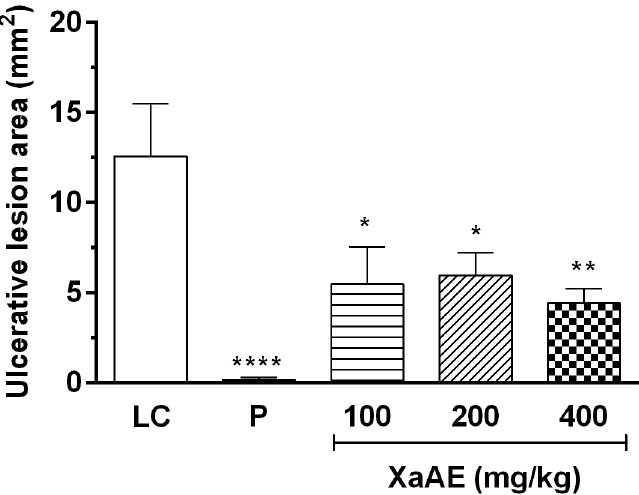
Figure 7. Gastroprotective effect of the aqueous extract of X. americana (XaAE ) stem bark on indomethacin-induced (30 mg/kg, s.c.) gastric lesions in Wistar rats. Animals received 0.9% NaCl solution (lesioned control, LC, 10 mL/kg, orally), pantoprazole (P, 40 mg/kg, orally) or XaAE (100, 200 and 400 mg/kg, orally). Results were expressed as mean ± SEM (6–8 animals/group). Statistically different when compared to the lesioned control group (ANOVA, followed by Dunnett’s multiple comparisons test, * p < 0.05, ** p < 0.005, **** p < 0.0001).